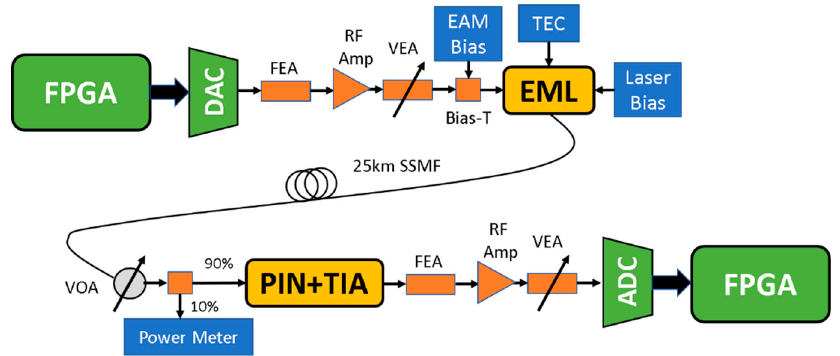
Figure 5. Reconfigurable optical transceiver real-time experimental system setup. FEA, fixed electrical attenuator; PIN + TIA, integrated photodetector and transimpedance amplifier.